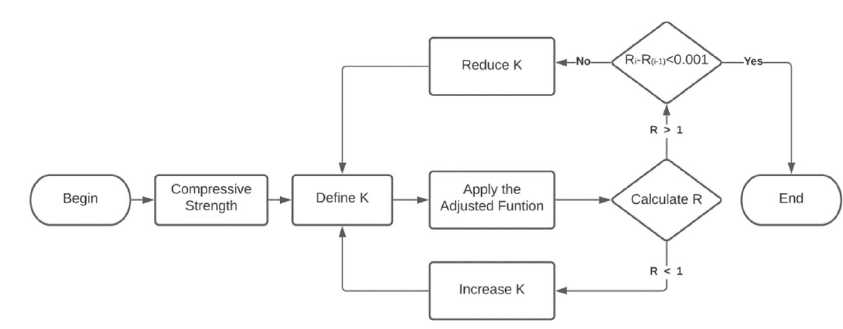
Figure 2. Flowchart of the iterative process .